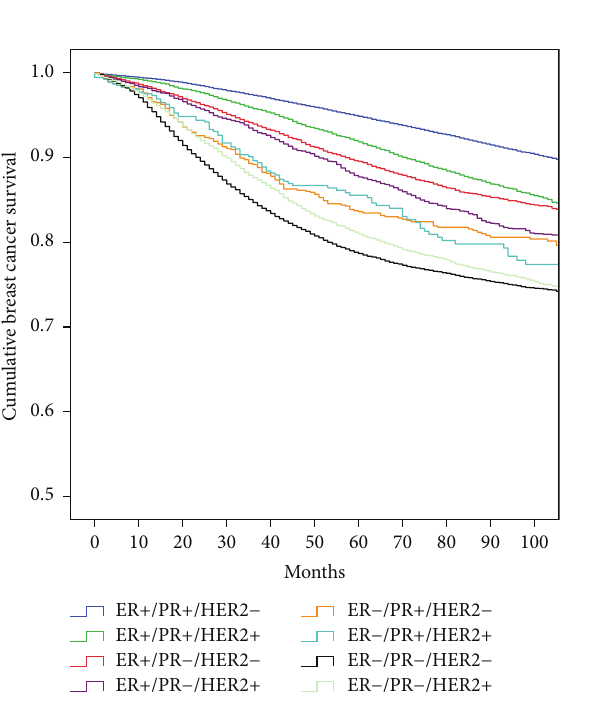
Figure 1: Unadjusted Kaplan-Meier breast cancer specific survival of the eight ER/PR/HER2 subtypes in 143,184 cases from the Cal- ifornia Cancer Registry